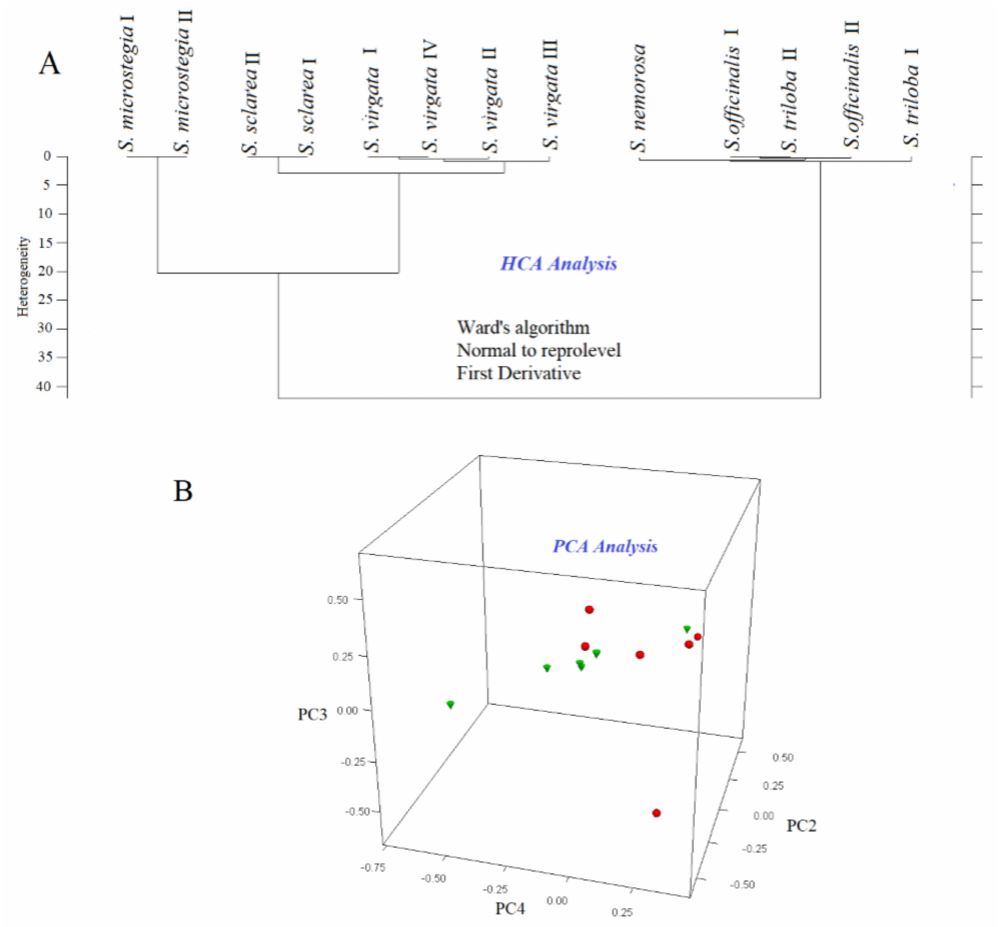
Figure 4. ( A ) Dendrogram of HCA (Ward’s Algorithm) of the seed samples of Salvia species ( B ) Three dimensional (3D) PCA map of the seed samples of Salvia